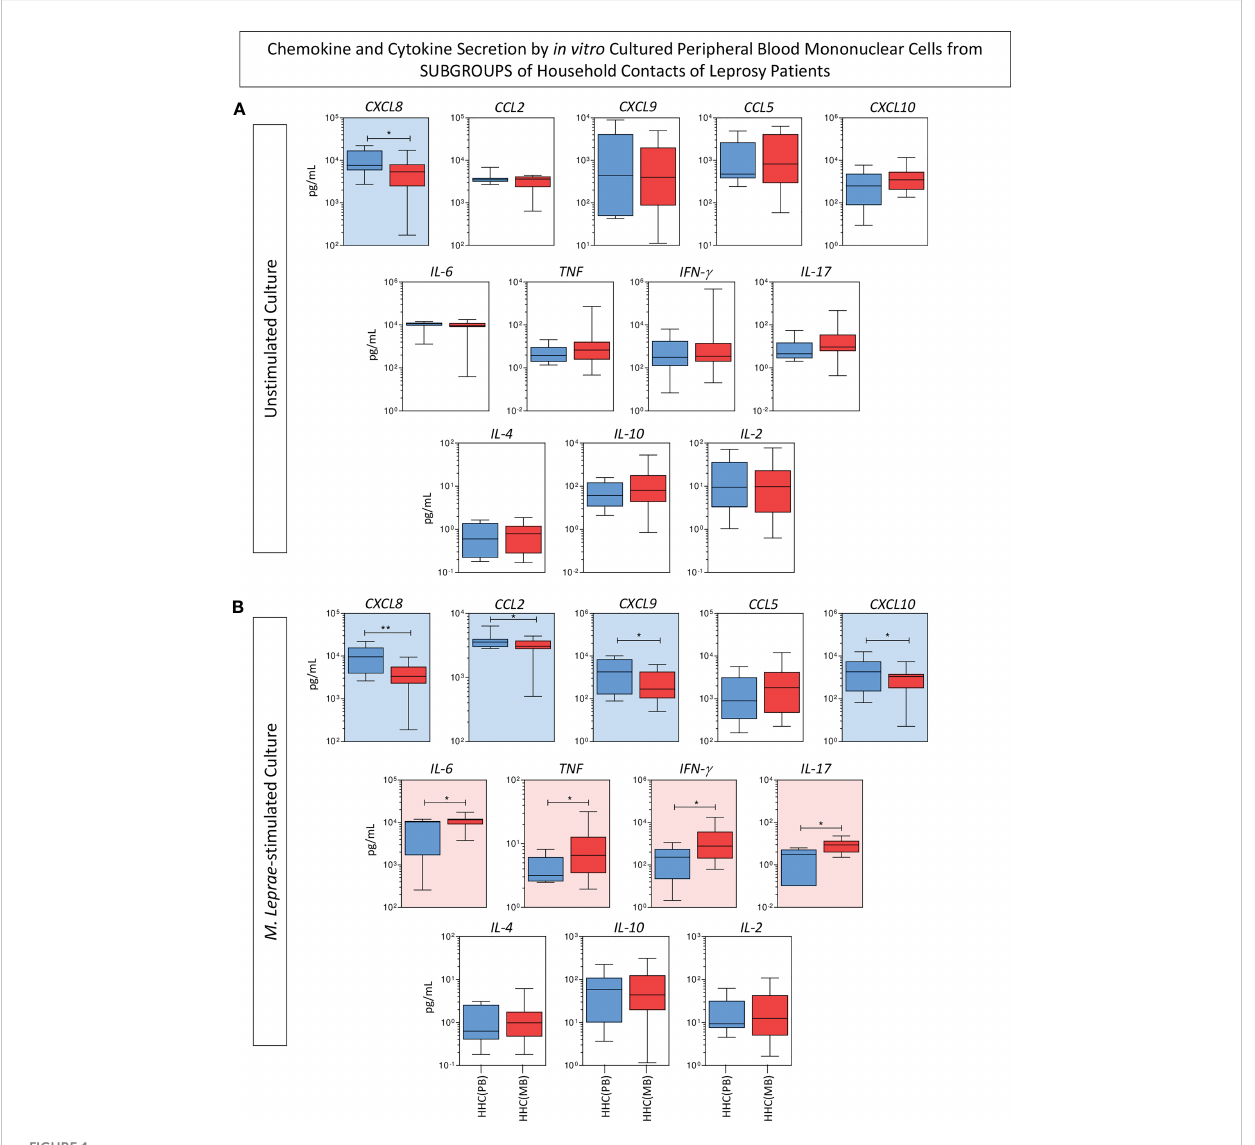
FIGURE 1 Panoramic overview of chemokines and cytokines secretion by in vitro cultured peripheral blood mononuclear cells from subgroups of household contacts of leprosy patients. The levels of chemokines (CXCL8, CCL2, CXCL9, CCL5, CXCL10) and cytokines (IL-6, TNF, IFN- g , IL-17, IL-4, IL-10